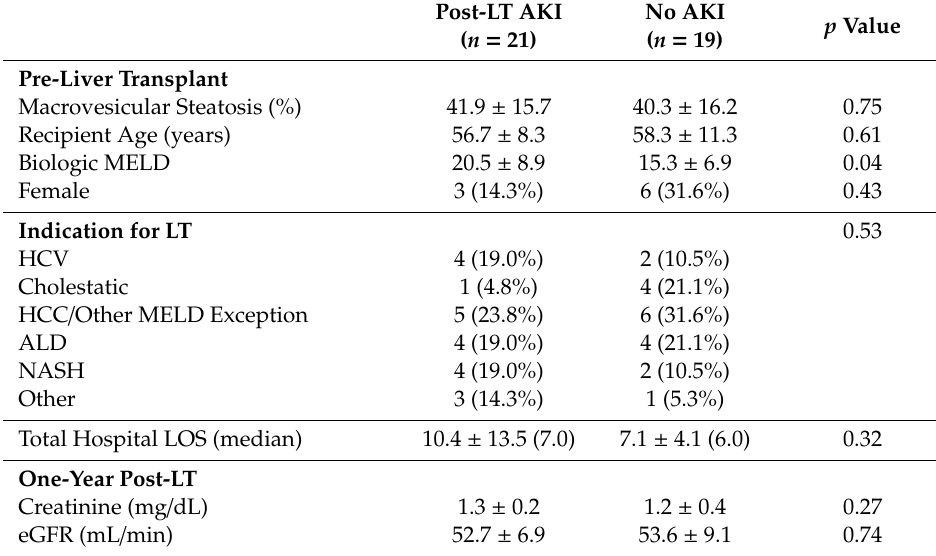
Table 2. Moderately Steatotic Graft Subgroup